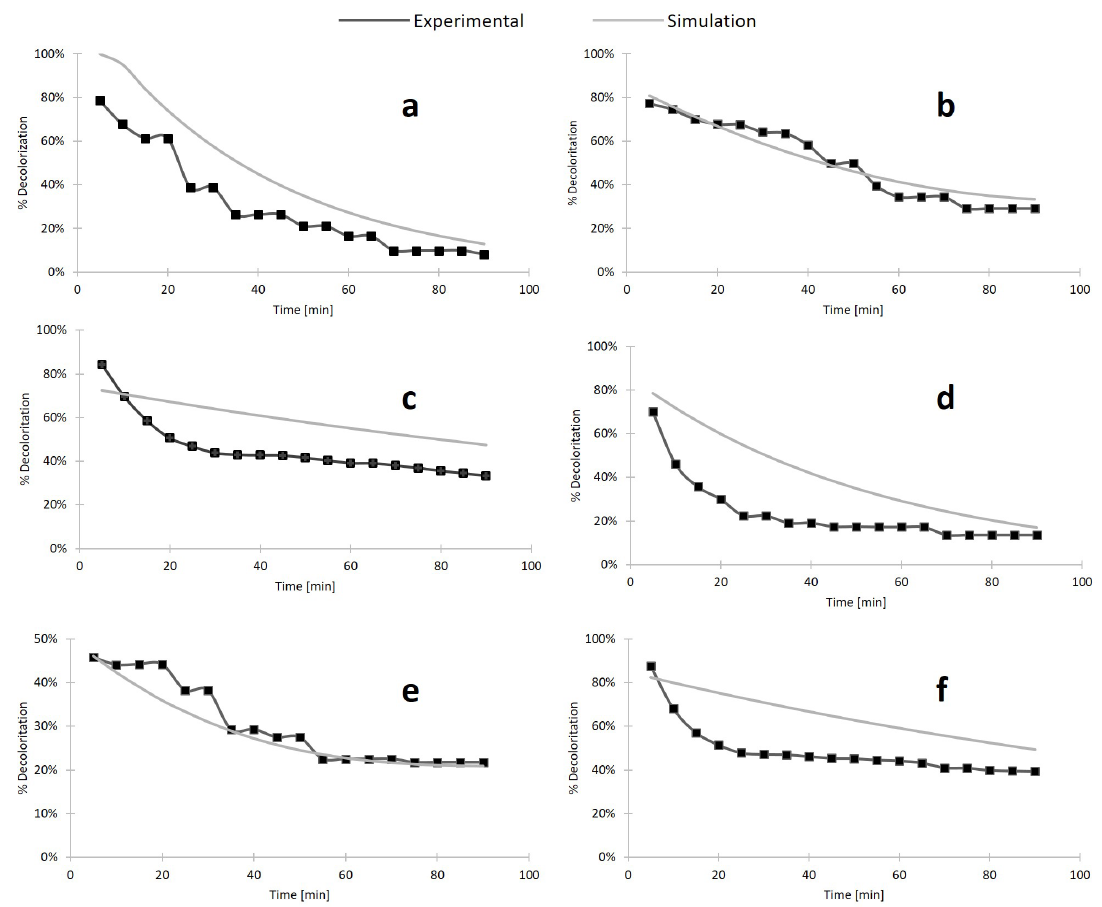
Figure 8. Experimental and simulation results of ( a ) Free filters, ( b ) FreeNW filters, ( c ) FreeNA filters, ( d ) IL biofilters, ( e ) ILNW biofilters, and ( f ) ILNA biofilters. Simulation results were used to determine the di ff usion and dispersion constants of the Brinkman equations. Nanomaterials 2020 , 9 , x